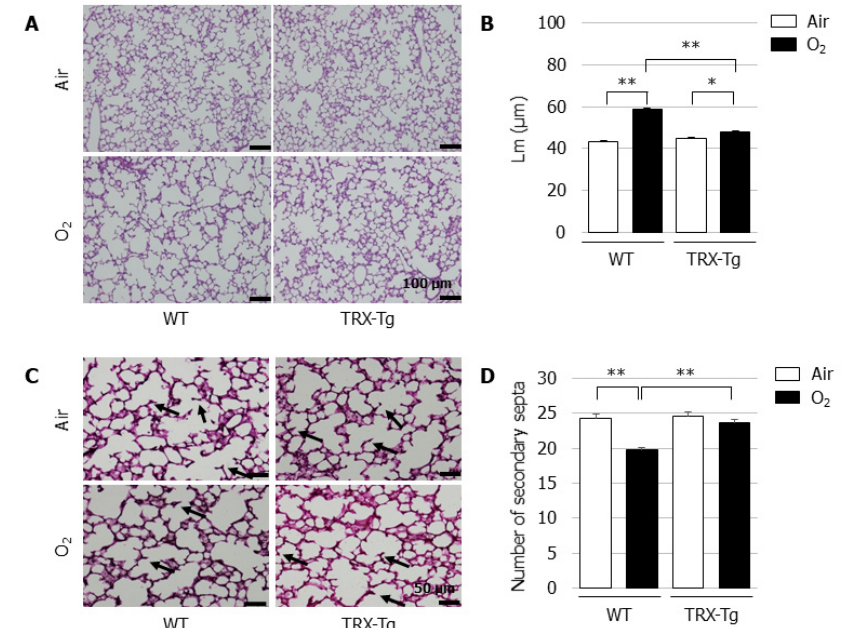
Figure 3. Alveolar development during recovery from neonatal hyperoxic exposure on day 14. ( A ) H&E- stained histological sections. Scale bar = 100 µm (magnification ×100). ( B ) Lm ( n = 6, per group). Lm was assessed in six nonoverlapping fields of lung parenchyma in one tissue section per animal. Animals were exposed to air (open bars) or O 2 (filled bars). ( C ) Elastin-stained histological sections. The black arrows indicate elastin-positive secondary septa. Scale bar = 50 µm (magnification × 200). ( D ) Number of secondary septa ( n = 6 per group). The number of secondary septa was assessed in six nonoverlapping fields of lung parenchyma in one tissue section per animal. Animals were exposed to air (open bars) or O 2 (filled bars). Data are shown as means ± SEM. Comparisons between groups were performed using